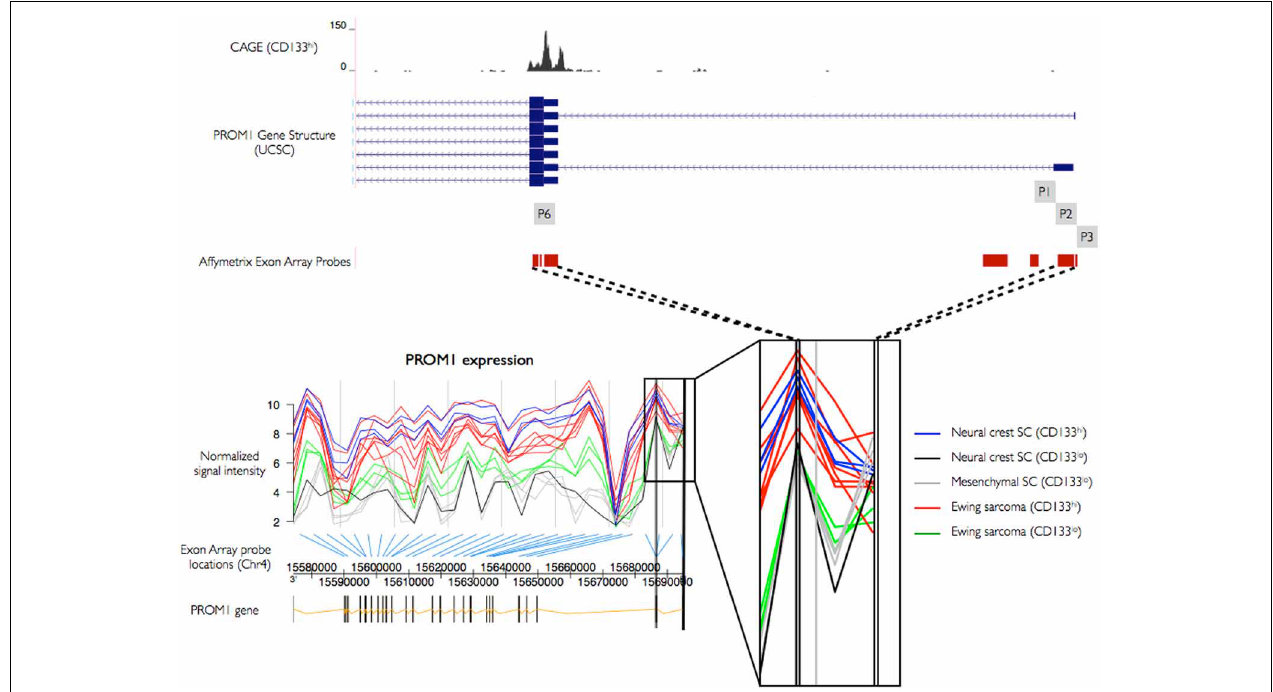
FIGURE 4 | PROM1 promoter activity using exon arrays. Transcript wide expression pattern of PROM1 measured by Affymetrix exon arrays with specific probes targeting exonic regions. Y-axis: normalized signal intensity (expression level). X-axis: genomic coordinates of the transcript. Expression